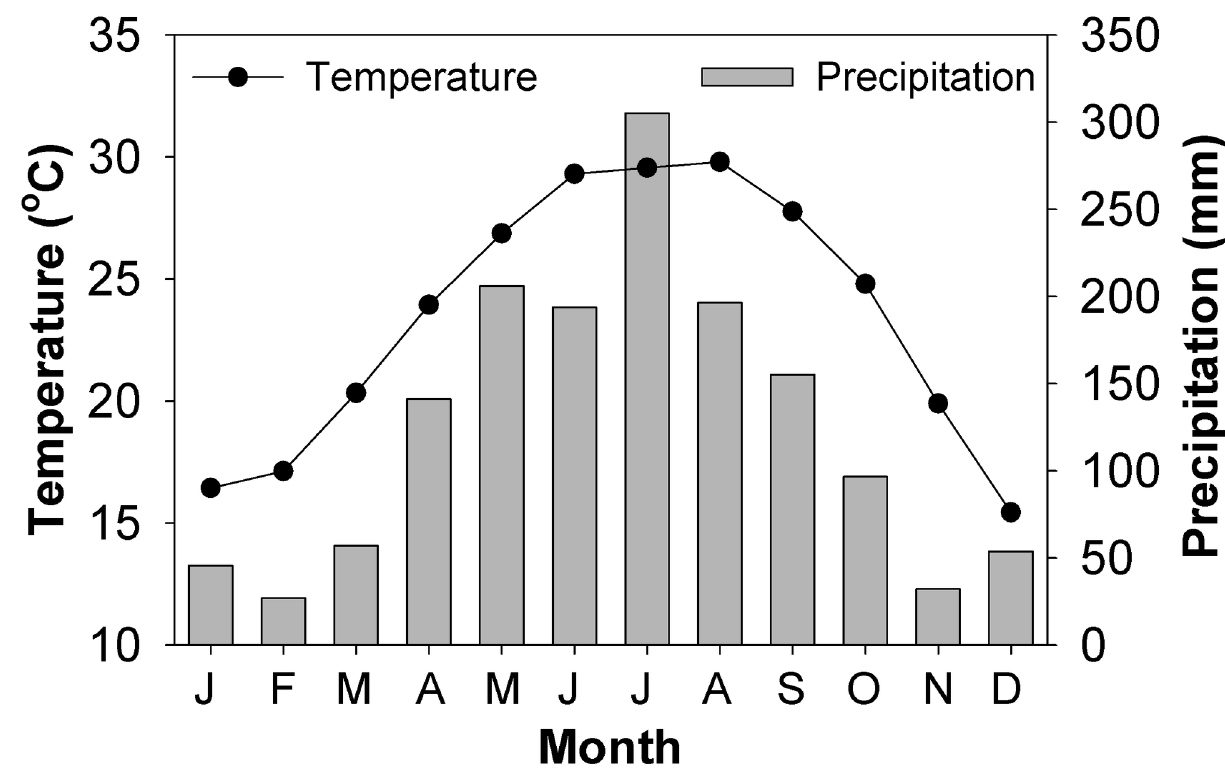
Figure 1. Mean monthly dynamics of temperature and precipitation in the study site from 1999 to 2009. doi: